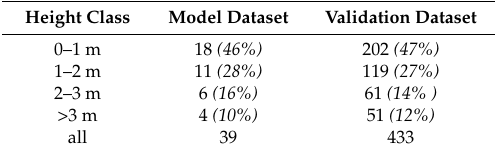
Table 3. Number of trees in the modeling and validation